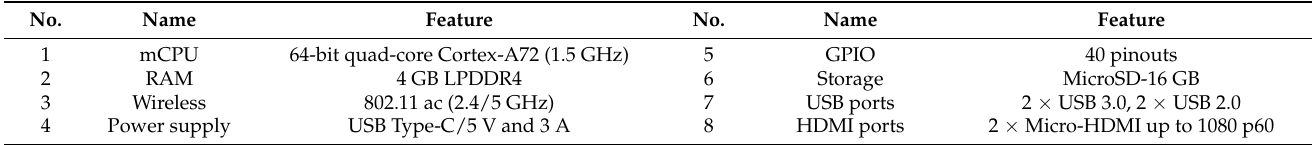
Table 2. Main specifications of Raspberry Pi 4